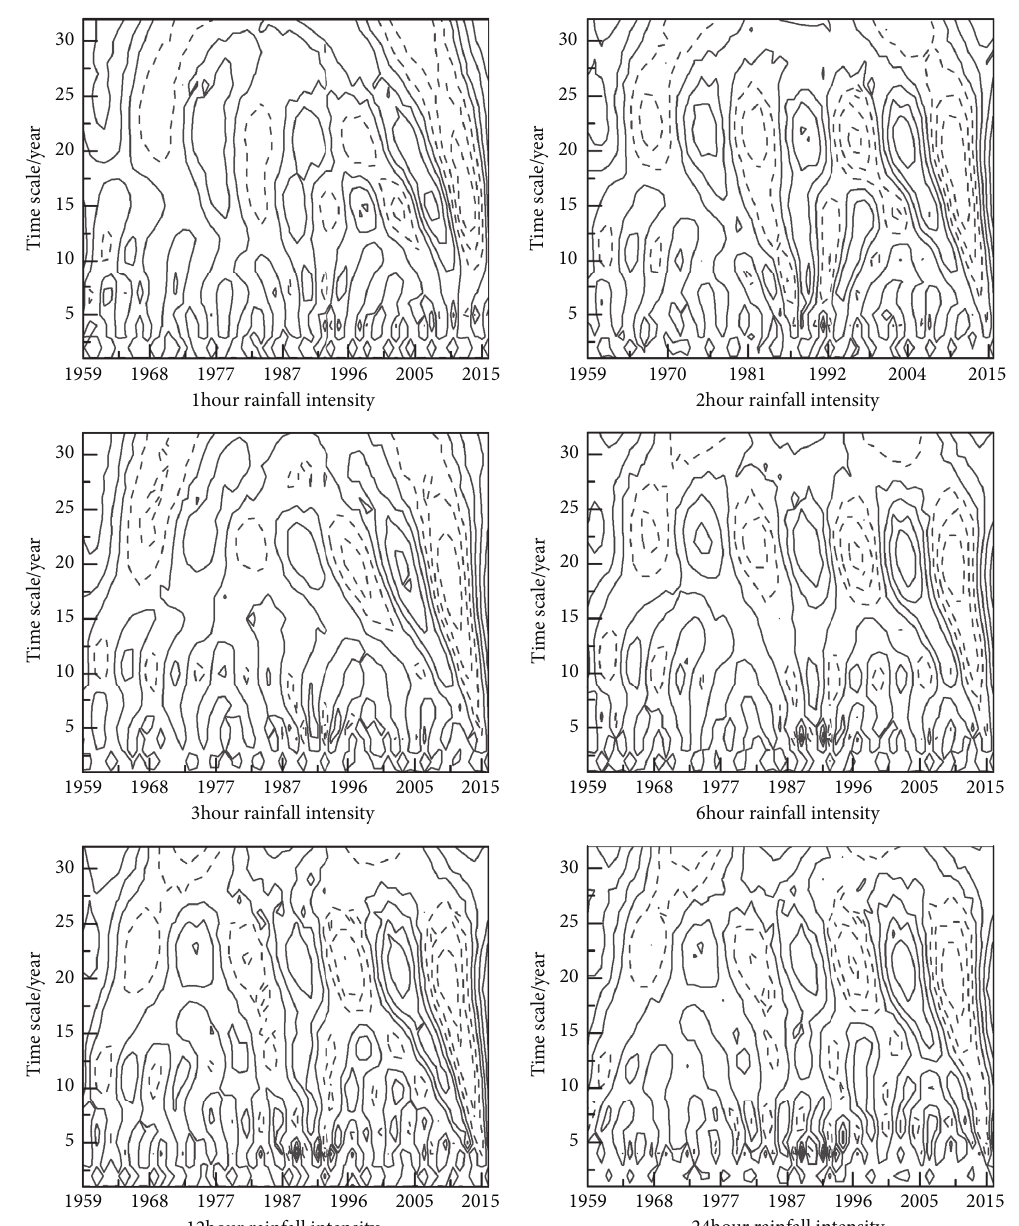
Figure 9: Contour plots of the real parts of the wavelet coefficients of the intensities of the precipitation with different durations in the study area from 1959 to